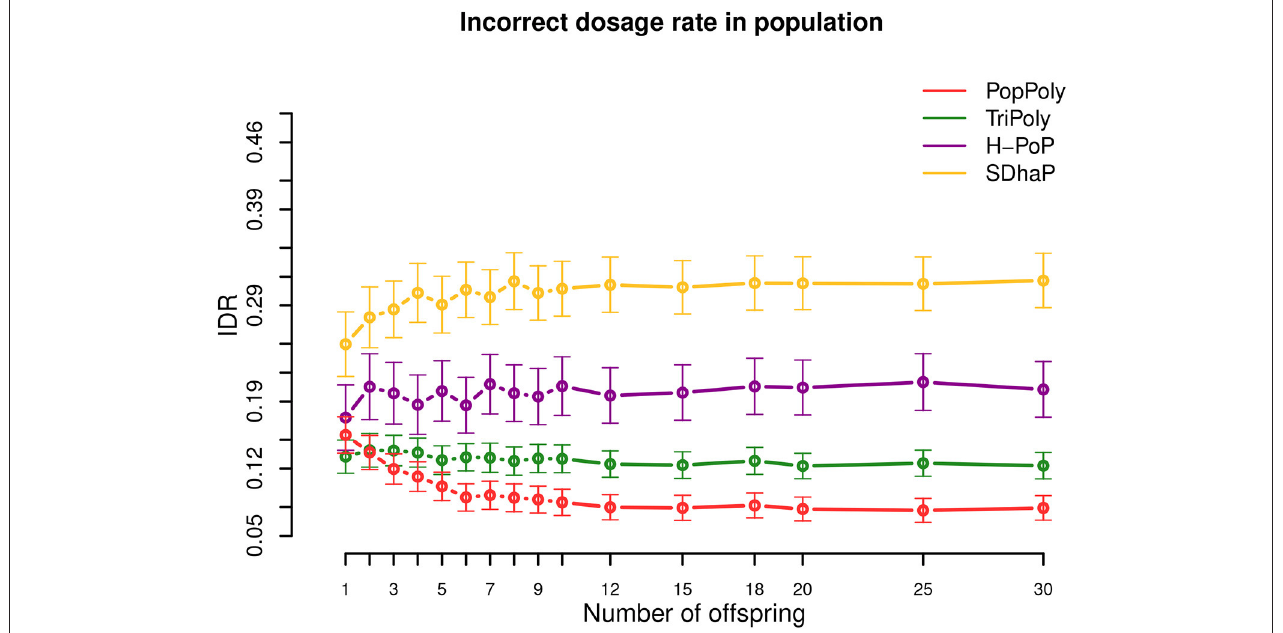
FIGURE 4 | Incorrect dosage rate (IDR) in the population against the number of offspring reported by PopPoly (red), TriPoly (green), H-PoP (purple), and SDhaP (yellow) for simulated tetraploid potato populations.